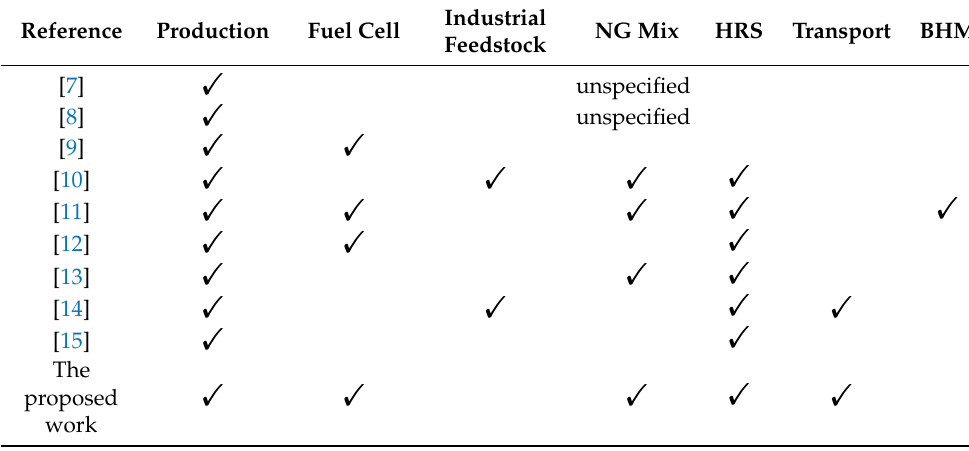
Table 1. Summary of the services found in the literature review and in the present